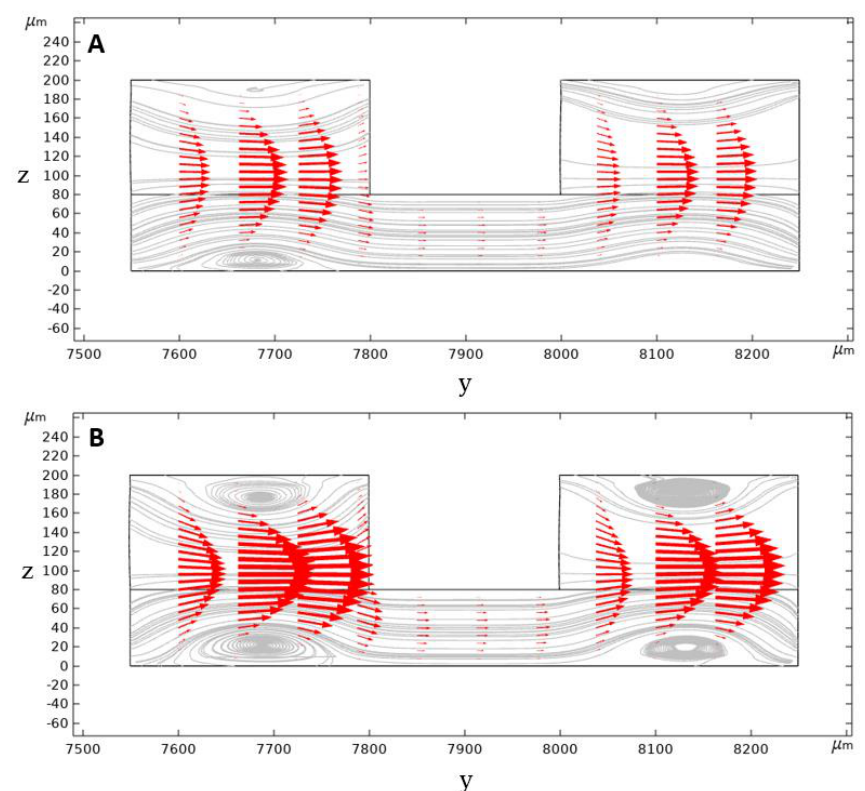
Figure 6. Calculated secondary flow streamlines and velocity vectors in the second loop of the designed spiral microchannel cross-section at x = 0. Velocity vectors are being directed from the inner wall to the outer wall in the middle passway with: ( A ) 2 mL/min, ( B ) 3 mL/min inlet flow rate (Note that in this figure the origin of y-direction lies on the origin of the spiral microchannel).